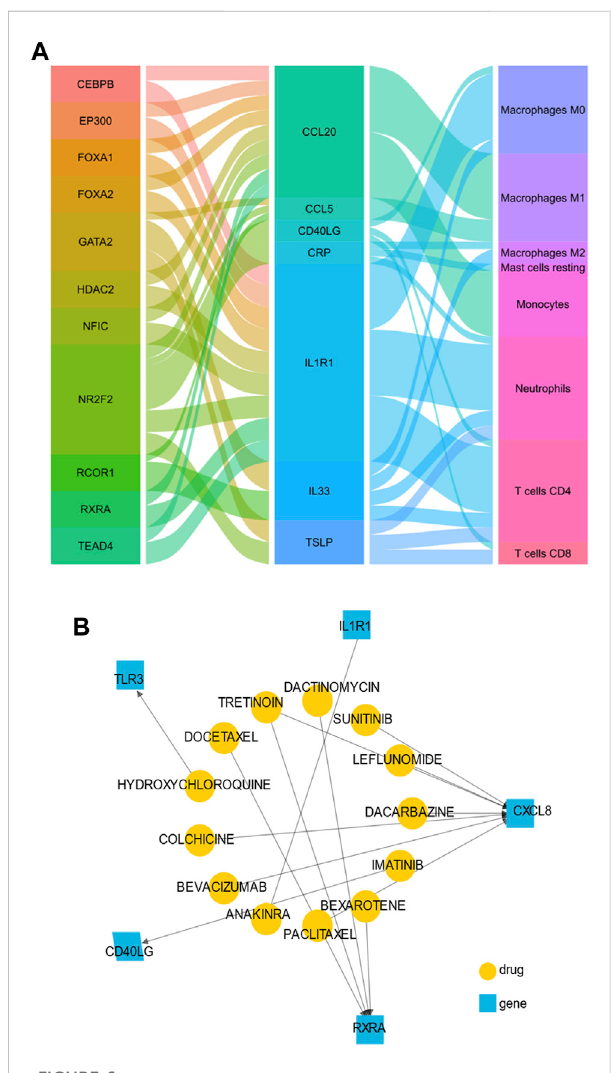
FIGURE 6 The transcription factors (TFs) regulated network and target drugs in OSA patients. (A) The alluvial plot showing the regulatory network of TFs-genes-immune cells. The left column represents predicted TFs, the middle column represents immune-related hub genes, the right column represents immune cells, and the edge represents the relationship between them. A larger edge width indicates the number of TFs and immunecells (B) Drug-gene network using drug-centric fashions. Yellow circles indicate predictive drug, and blue squares indicate immune-related hub